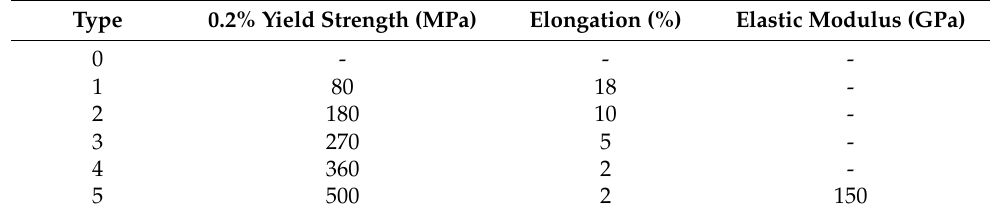
Table 4. Mechanical properties by type specified in ISO